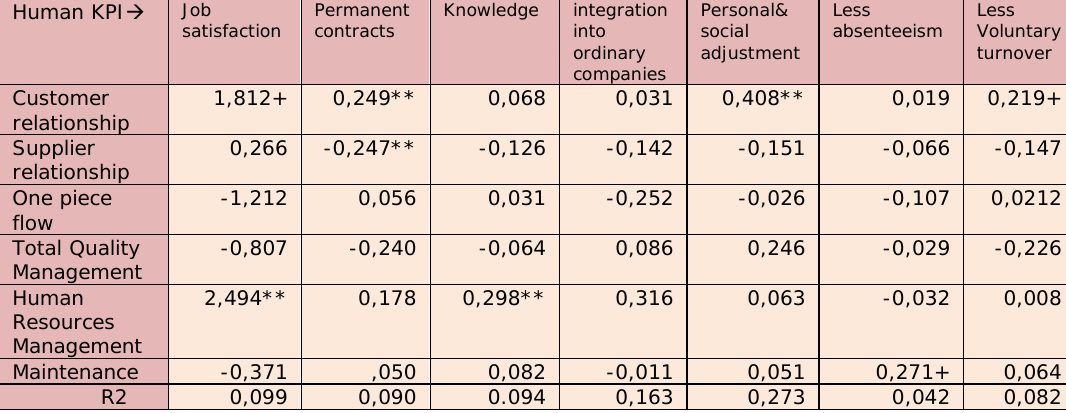
Table 3. Relationship between human KPIs and alternative tools to mass production (regression standardized